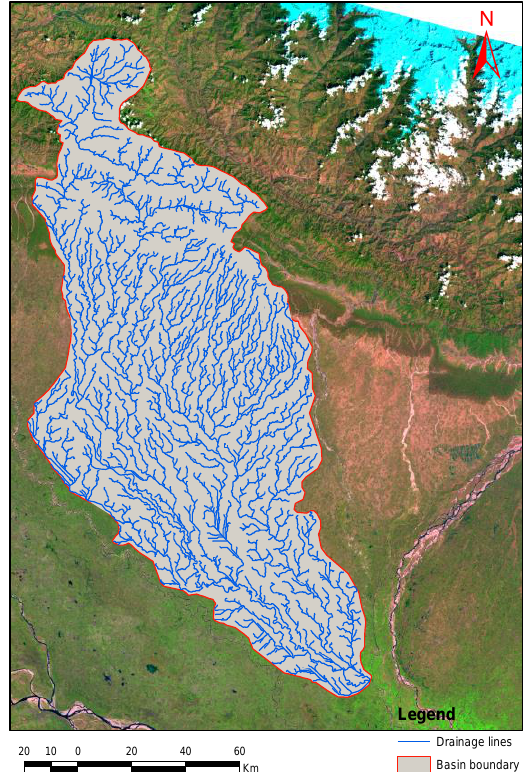
Fig.3.3: AWiFS image with Bagmati basin and drainage